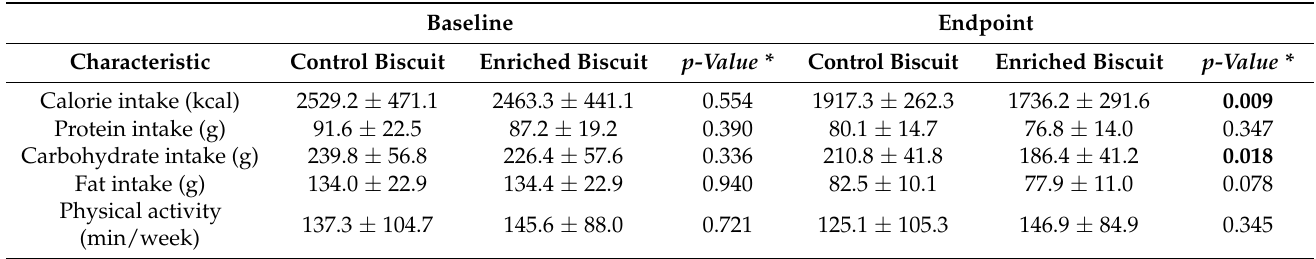
Table 4. Energy and nutrient consumption and energy expenditure of the subjects at baseline and at the end of the intervention.